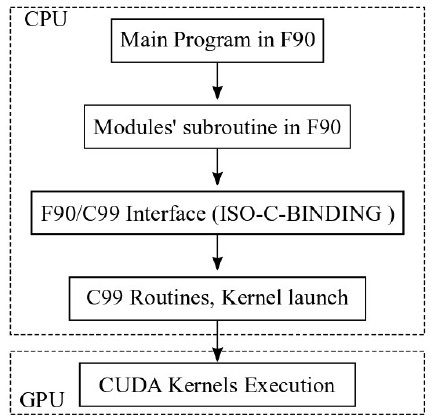
Figure 2. Command chain scheme for the CPU–GPU